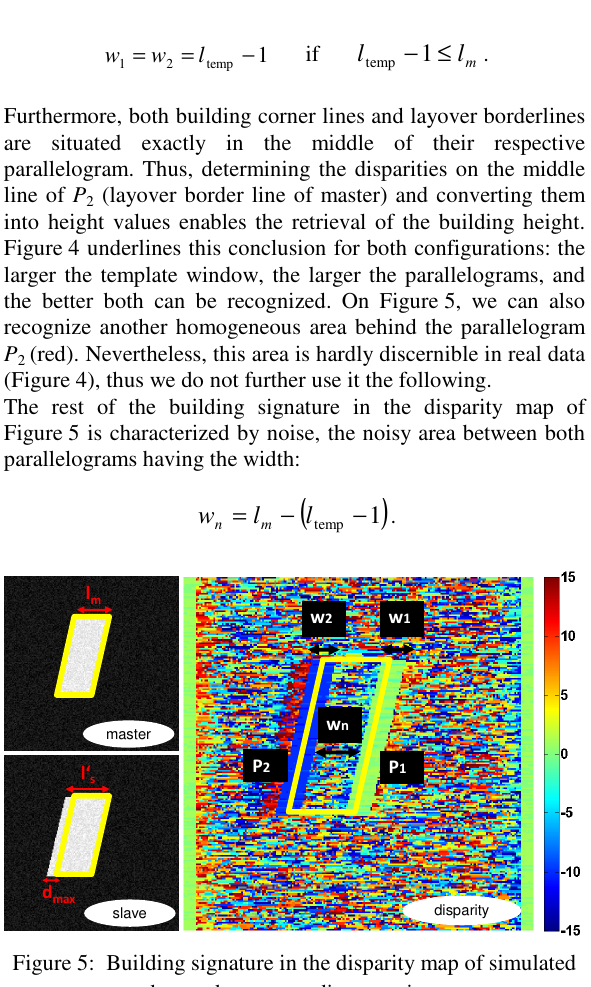
Figure 5: Building signature in the disparity map of simulated data and corresponding notations